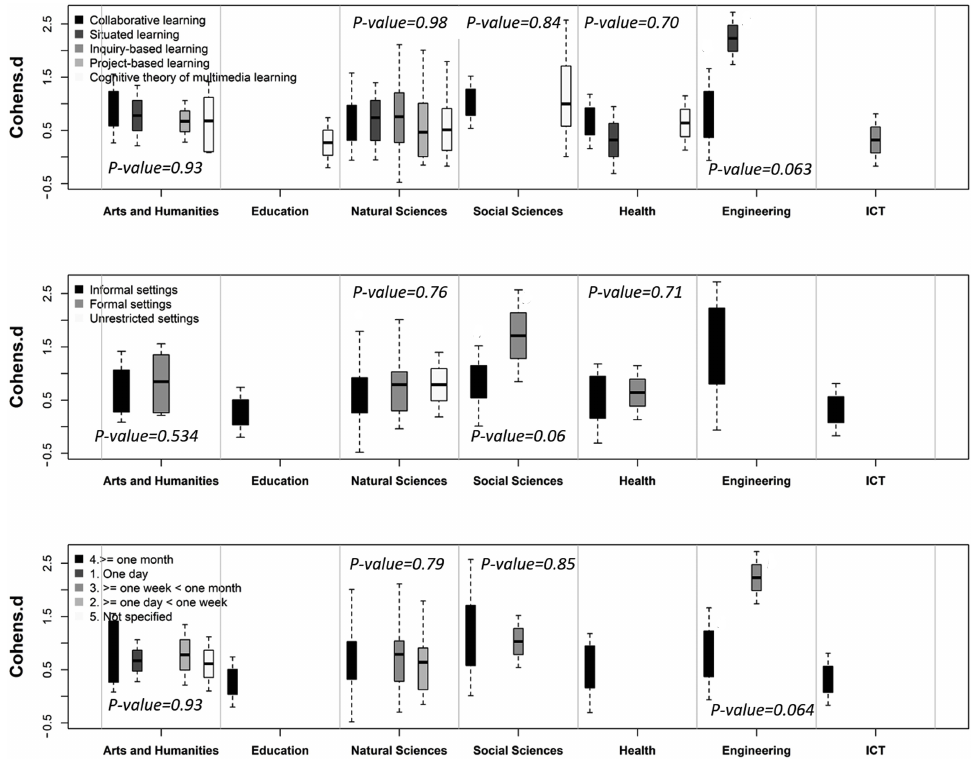
Figure 5. Cross-analysis between different fields of education and the effect of AR integration